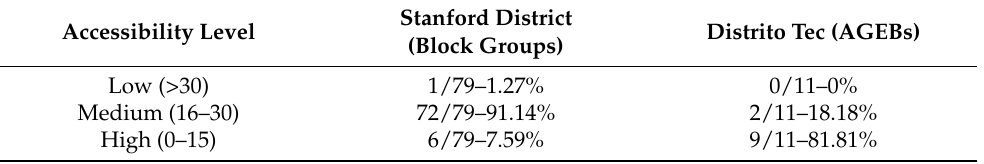
Table 11. Accessibility level to high schools traveling by bicycle per aggregation